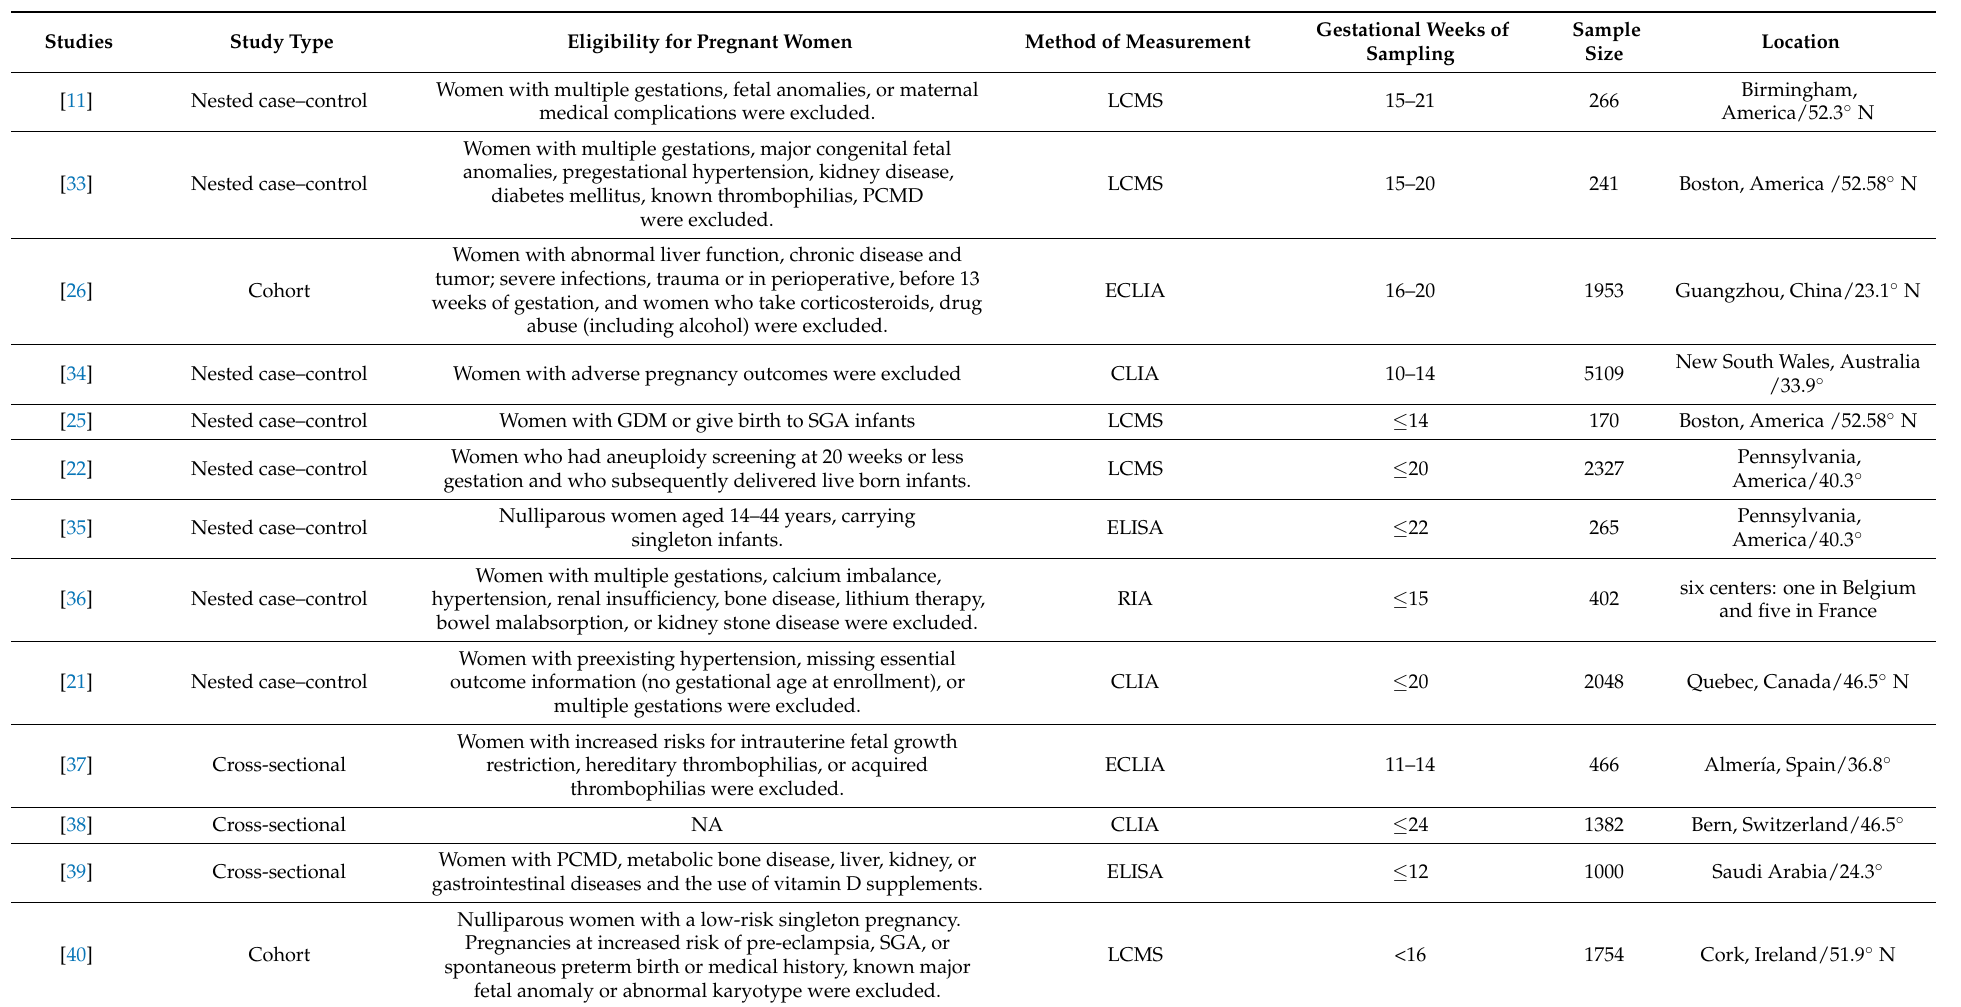
Table 1. Characteristics of included